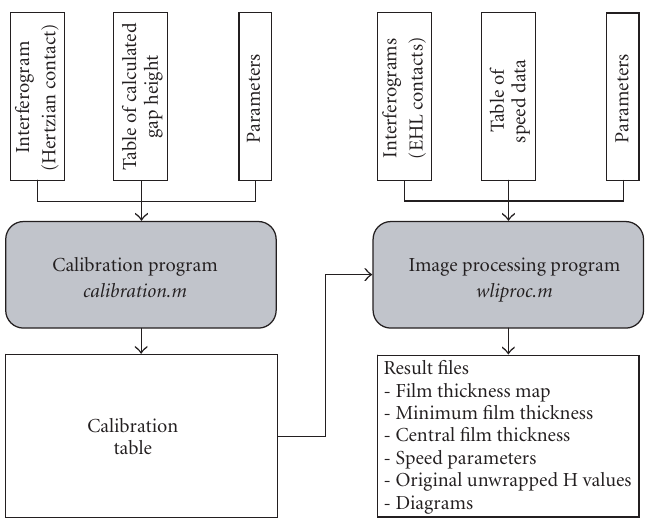
Figure 5: Structure of the two main programs and their interaction.